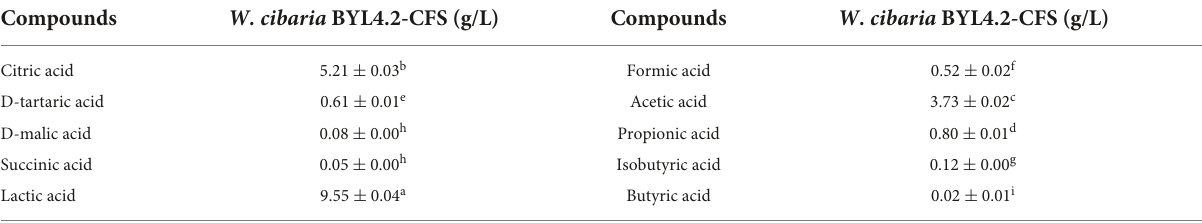
TABLE 2 The organic acids produced in the Weissella cibaria BYL4.2-CFS was quantitatively determined by HPLC.